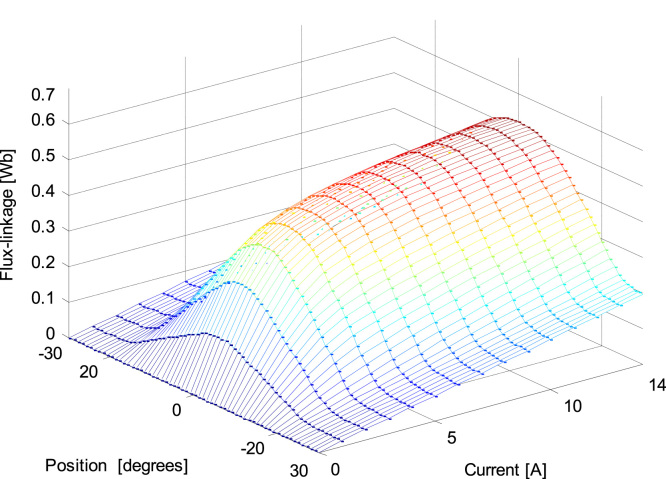
3-Dimensional representation of flux linkage [12].